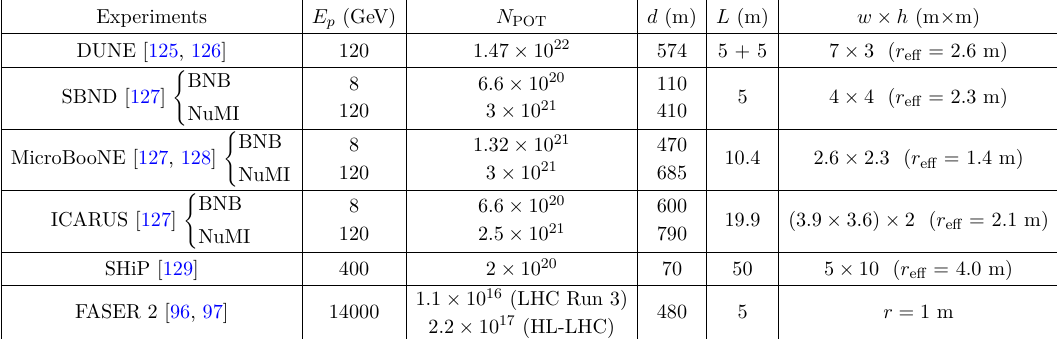
Table 1 . Detector specifications for various experiments. For DUNE, we have combined the lengths of the gaseous multi-purpose detector (5 m) and LArTPC (5 m). SBND, MicroBooNE, and ICARUS can serve as useful facilities as off-axis detectors with respect to the NuMI beam, along with the default on-axis BNB. Therefore, we record the locations and geometries for both beams.